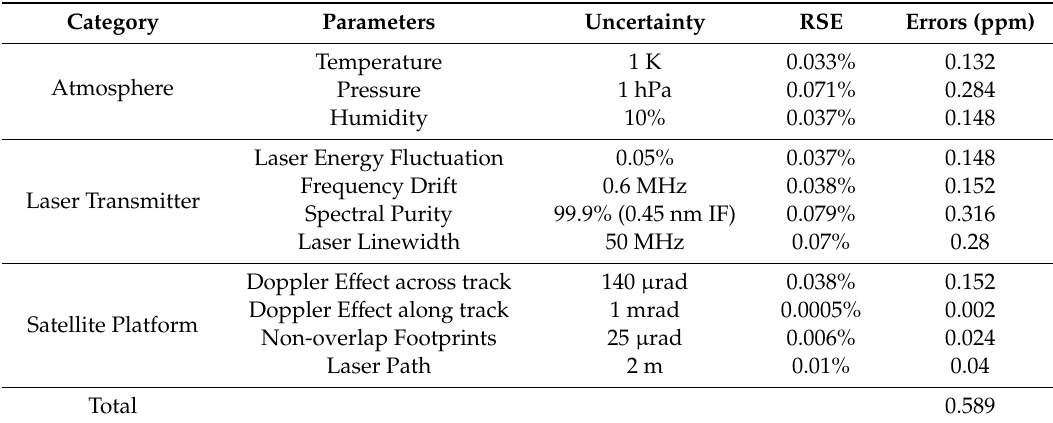
Table 3. Summary results of various systematic errors of AC-IPDA lidar.